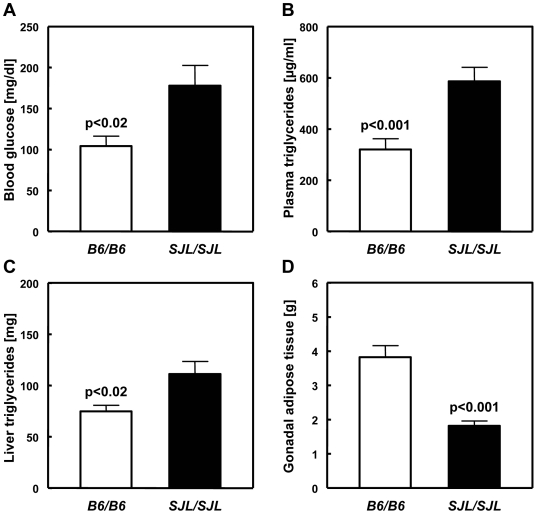
Effect of the Zfp69SJL allele in B6.V-Lepob mice.
Nidd/SJL was combined with a B6.V-Lepob background by intercross, and male B6-ob/ob.SJL-Nidd/SJL (SJL/SJL) were compared with obese control mice (B6/B6). Postabsorptive (6 h fasting) blood glucose levels (A), liver triglyceride content (C), and weight of gonadal fat pads (D) were determined at week 13, plasma triglycerides (B) at week 28. Data represent means±SE of 10 (A,C,D) or 24 mice (B).